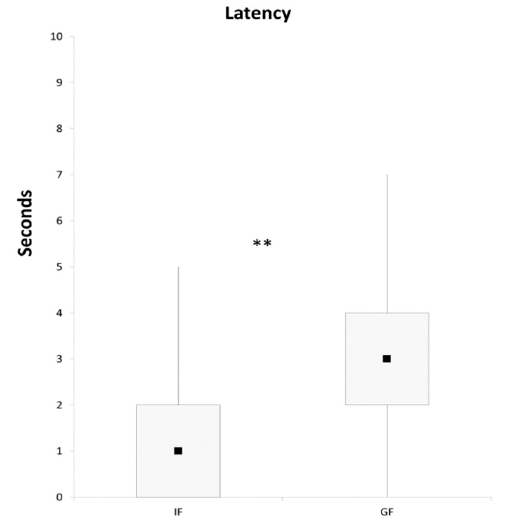
Figure 2. The latency of correct choices of intact (IF) and gonadectomized (GF) female dogs. Black squares: medians; boxes: quartiles; thin vertical lines: minimum and maximum values. ** p < 0.05.